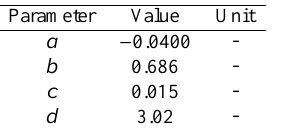
Table 2 Chemical parameters in evolution Eq. (7).